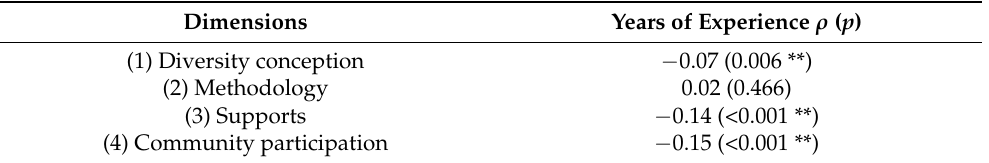
Table 4. Correlations between The Evaluation of Teacher Preparation for Inclusion Questionnaire (CEFI-R) dimensions and the teachers’ years of teaching experience.